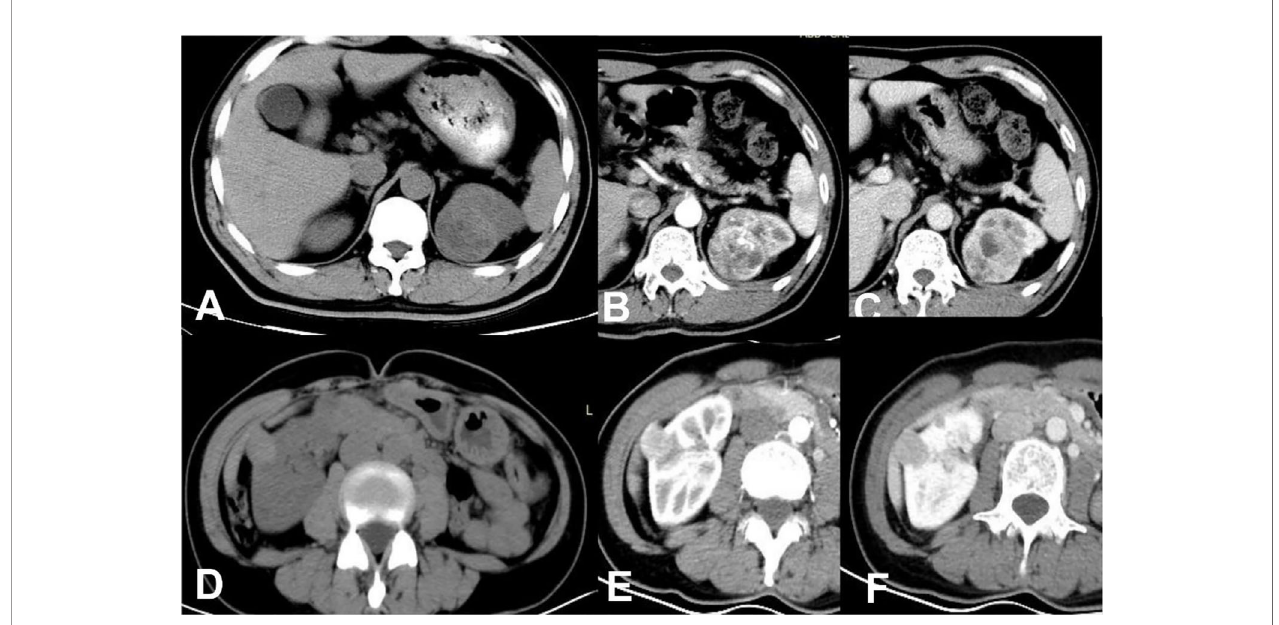
FIGURE 3 | ccRCC in a 48-year-old male, which presented not-high attenuation in plain scanning (A) , the attenuation of the mass parenchyma that could be enhanced was mixed. Besides, it was heterogeneous enhanced in CMP (B) or NP (C) , thus a score of 9 was assigned in this patient. RAML-wvf in a 61-year-old female showed homogeneous high attenuation in plain scanning (D) and homogeneous enhancement pattern in CMP (E) or NP (F) , thus a score of 0 was assigned in this patient and presented one of the minimum values in this model.